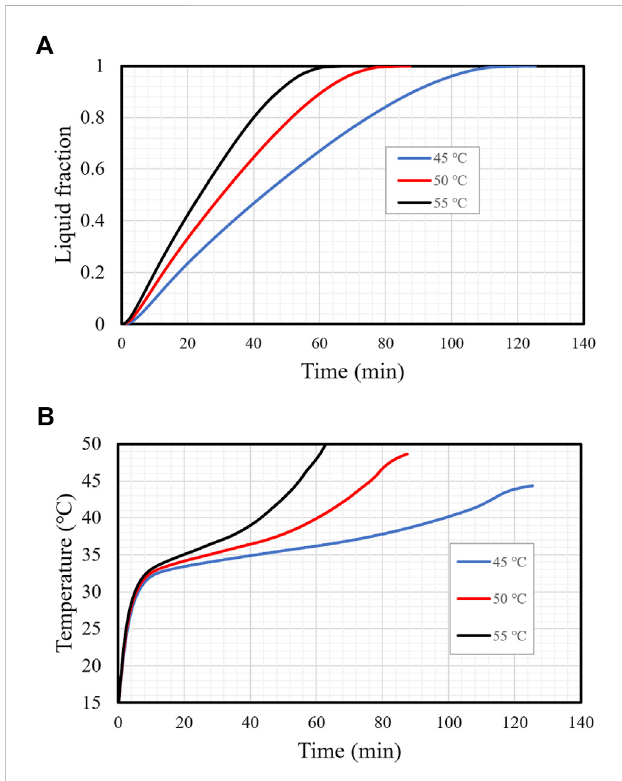
FIGURE 15 (A,B) Liquid fraction (A) and mean temperature (B) variation for different initial HTF